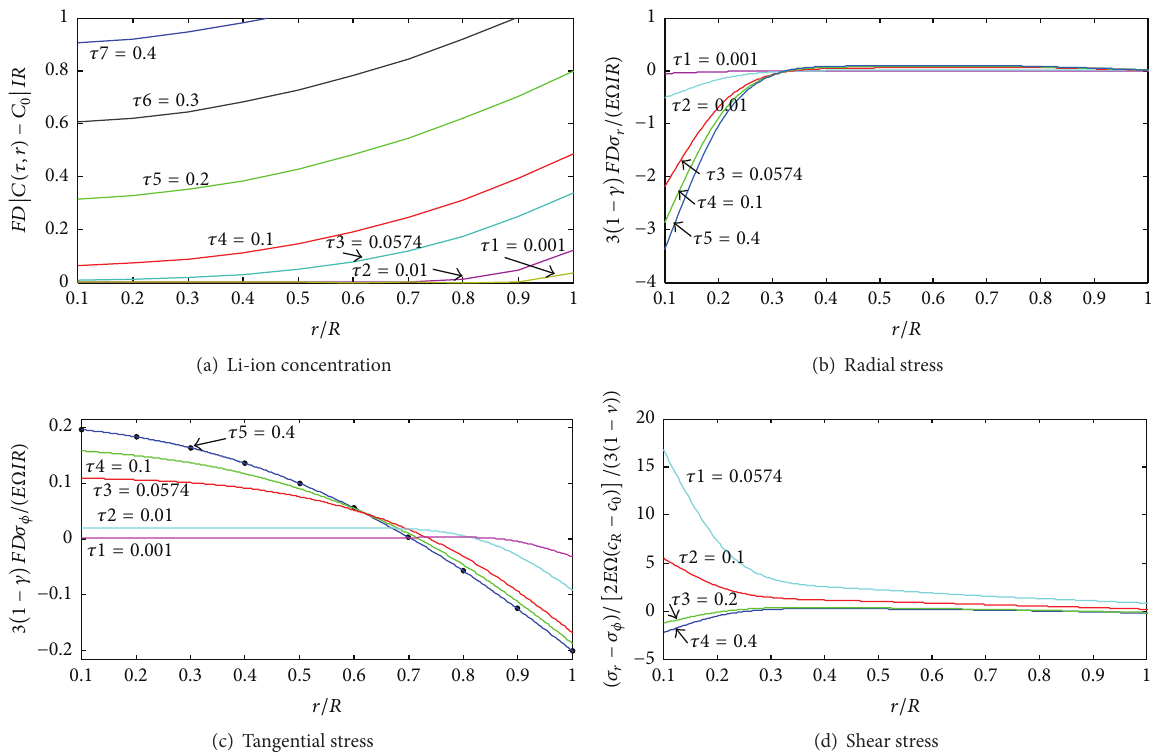
Figure 2: Characteristic profile of SPM in the insertion process under galvanostatic control.